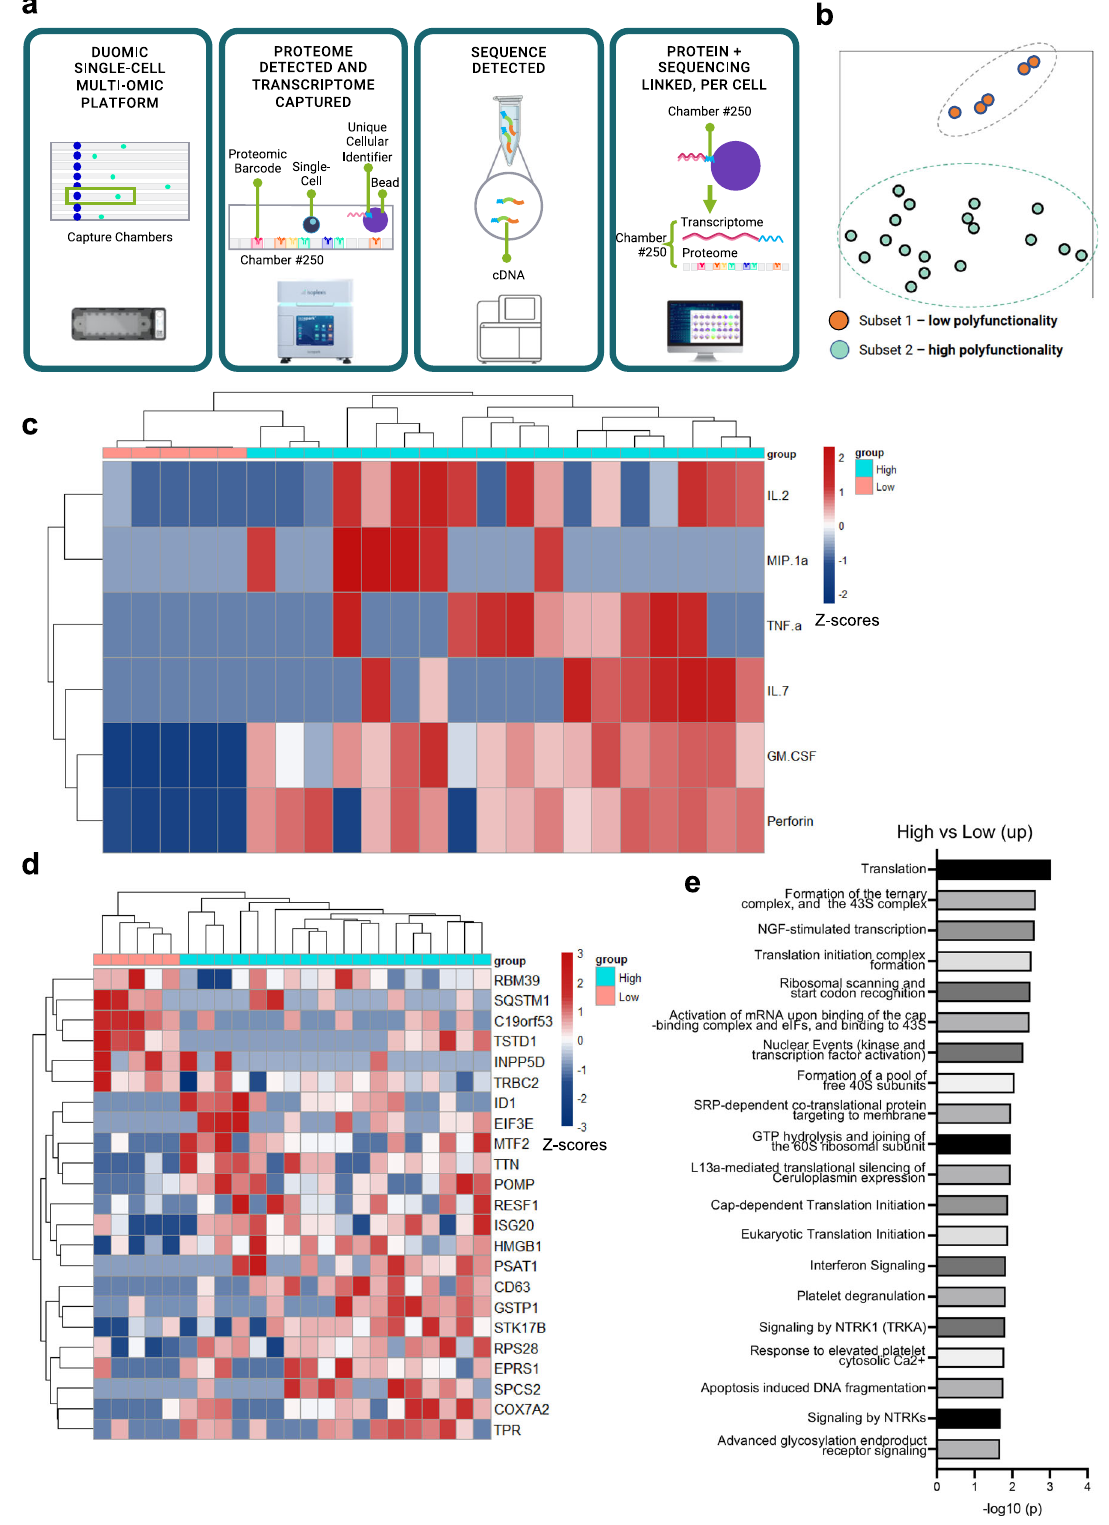
Fig.6|Single-cellanalysisofpolyfunctionalCD8 + D4-IgG4-CD28TMCARTcells at the mRNA and protein levels. a Flowchart of the single-cell protein and RNA expression analysis platform. The illustration was partially created with BioR- ender.com. b Identi fi cation of two CAR T clusters, low polyfunctionality and high polyfunctionality, in 23 CD8 + D4-IgG4H-CD28TM CAR T cells. c Functional